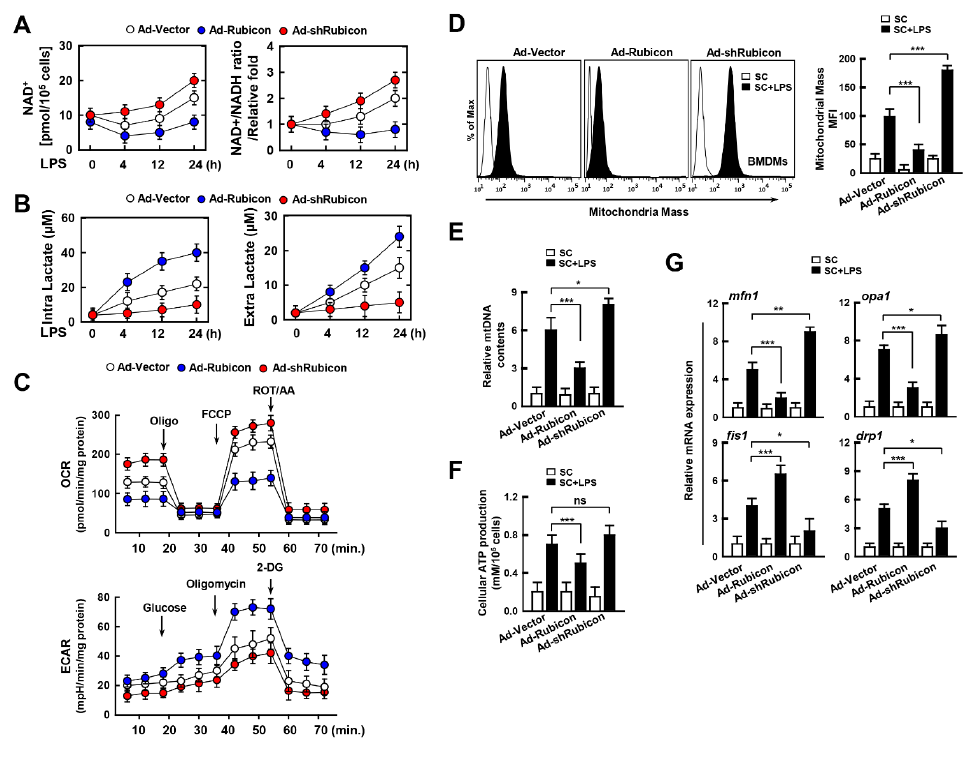
Figure 4. Effects of Rubicon in mitochondrial metabolism. BMDMs were transduced with Ad-Rubicon, Ad-shRubicon, or Ad-Vector (MOI = 10) for 2 days and stimulated with LPS (100 ng/mL) for indicated times. ( A ) NAD + /NADH ratio. ( B ) Lactate production. ( C ) The real-time measurement of OCR was analyzed by sequential treatment with oligomycin, FCCP, and rotenone/Actinomycin A, as an indicator of oxidative metabolism (left) or ECAR were analyzed by sequential treatment with glucose, oligomycin, and 2-DG, as an indicator of glucose oxidation. ( D ) Mitotracker fluorescence signals were assessed by a flow cytometric analysis. (Left) Representative histograms from seven independent replicates. (Right) Bar graph indicates the mitochondrial mass mean fluorescence intensities (MFIs). ( E ) Mitochondrial DNA (mtDNA) content in BMDMs measured by quantitative real-time PCR. The mtDNA content was normalized to nuclear DNA. ( F ) Cellular ATP production. ( G ) Quantitative real-time PCR of fusion or fission genes. Statistical significance was determined by Student’s t -test with Bonferroni adjustment (* p < 0.05; ** p < 0.01; *** p < 0.001) compared with Ad-Vector. Data shown are representative of seven independent experiments with similar results. Results are expressed as means ± SD of seven experiments.